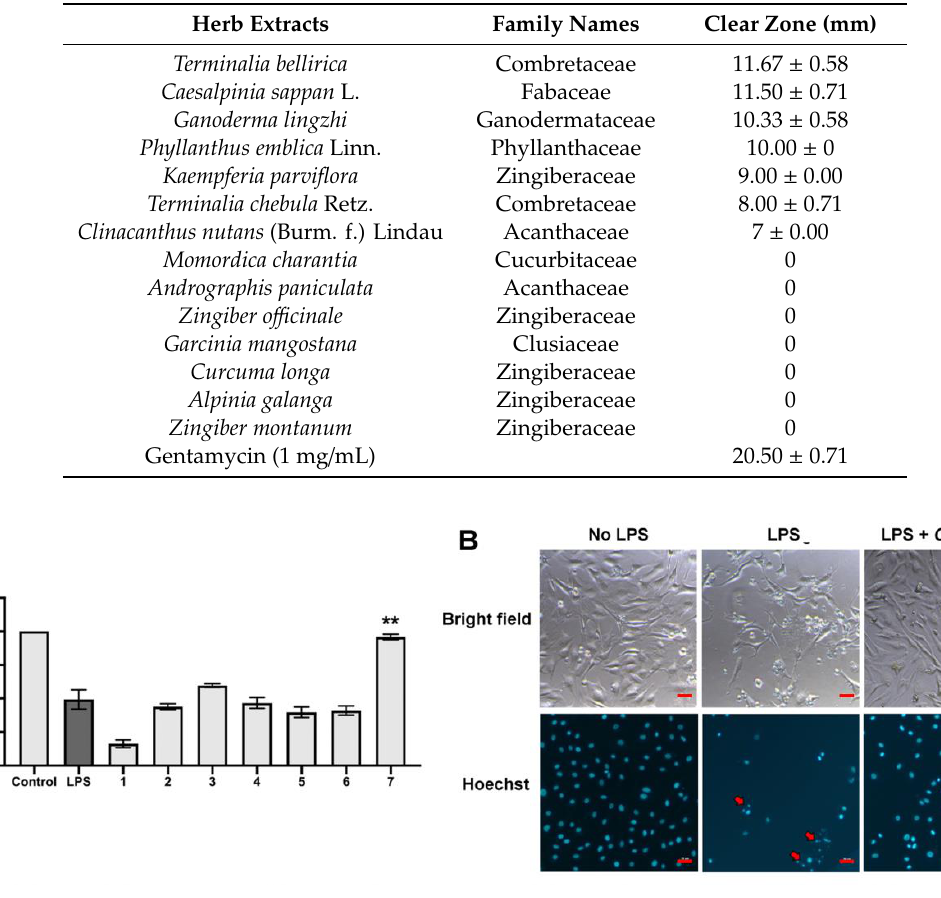
Figure 2. C. nutans extract rescuing effect on LPS-induced ECs. In total, seven of the herb extracts including T. bellirica (extract 1), C. sappan (extract 2), G. lingzhi (extract 3), P. emblica (extract 4), K. parviflora (extract 5), T. chebula (extract 6), and C. nutans (extract 7) were screened for their activity to protect LPS-induced cell death in ECs. ( A ) Cells were treated with LPS in the presence of herb extracts at the sub-lethal dose for 24 h and the cell viability was measured using Prestoblue ™ reagent (* indicates p < 0.05, ** indicates p < 0.01, and *** indicates p < 0.001). ( B ) The changes of cell morphology (upper) and nucleus staining (lower) upon LPS treatment were observed under the microscope. The red arrows indicated the fragments of nucleus. The scaled bar (20 micrometers) was indicated in red.